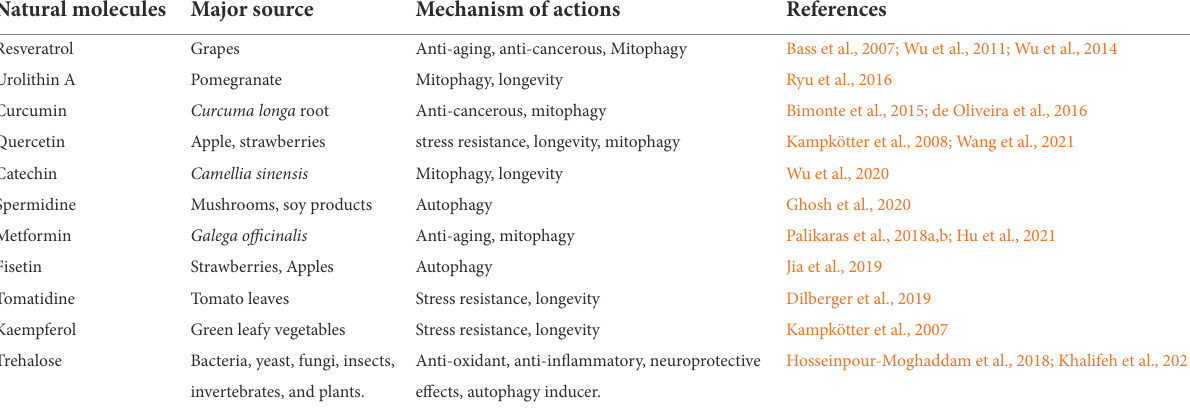
TABLE 2 List of natural molecules with their mechanism of